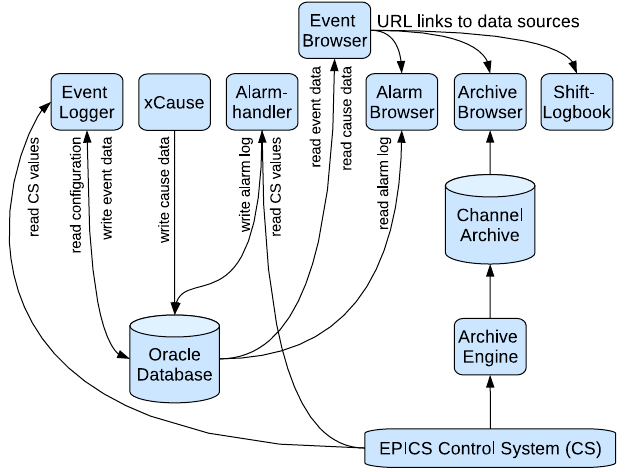
FIG. 1. (Color) System overview of the operation event